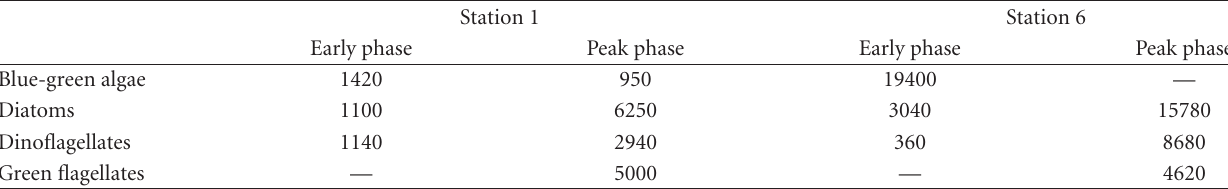
Table 2: Density (cells L − 1 ) of major phytoplankton groups during early and peak phases of summer monsoon at station 1 and 6 (“—” absent).